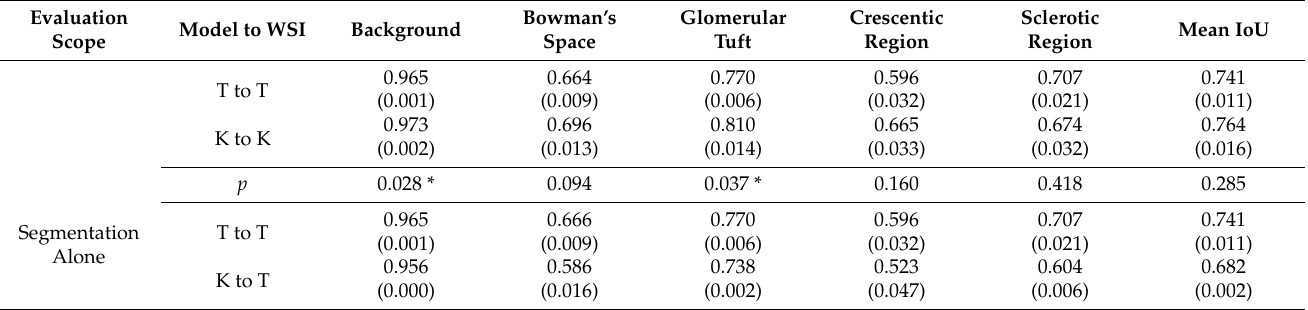
Table 4. Performance of glomerular